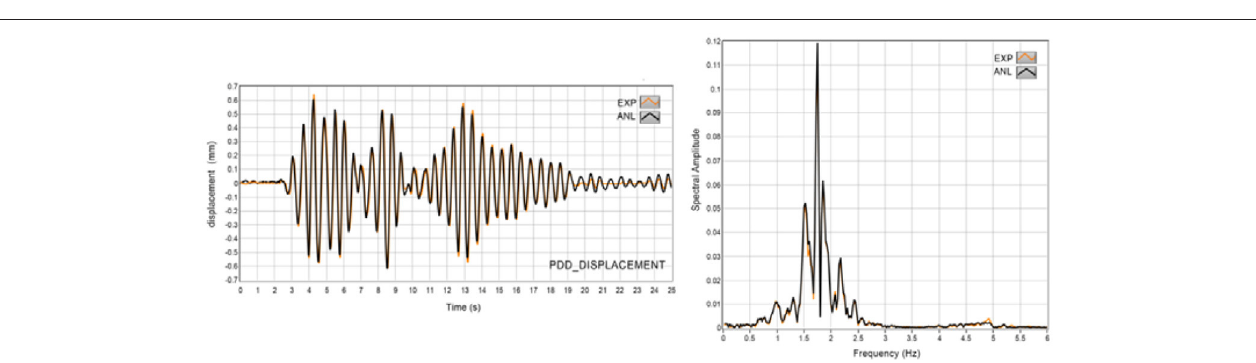
FIGURE 3 | Comparison between analytical and experimental response histories PDD